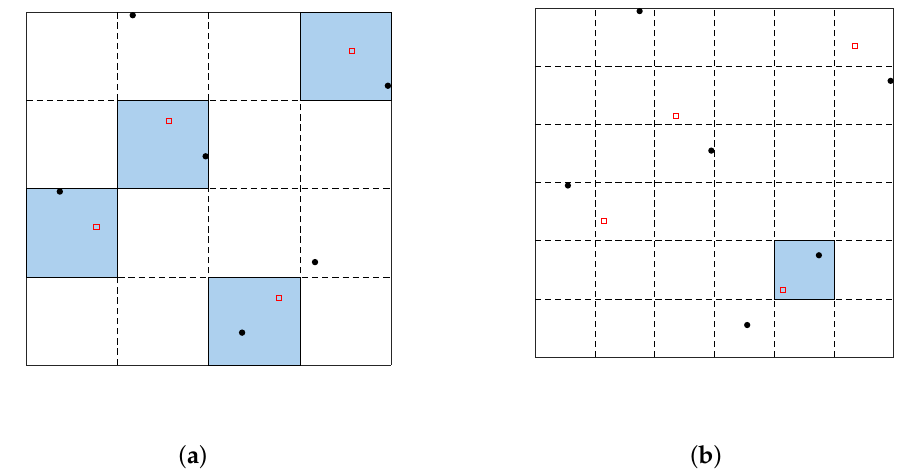
Figure 3. A poor design with some repeating rows. ( a ) the two-dimensional input region is divided into 4 × 4 cells, and some repeating rows lie in the same cell; ( b ) the two-dimensional input region is divided into 6 × 6 cells, and some repeating rows lie in the same